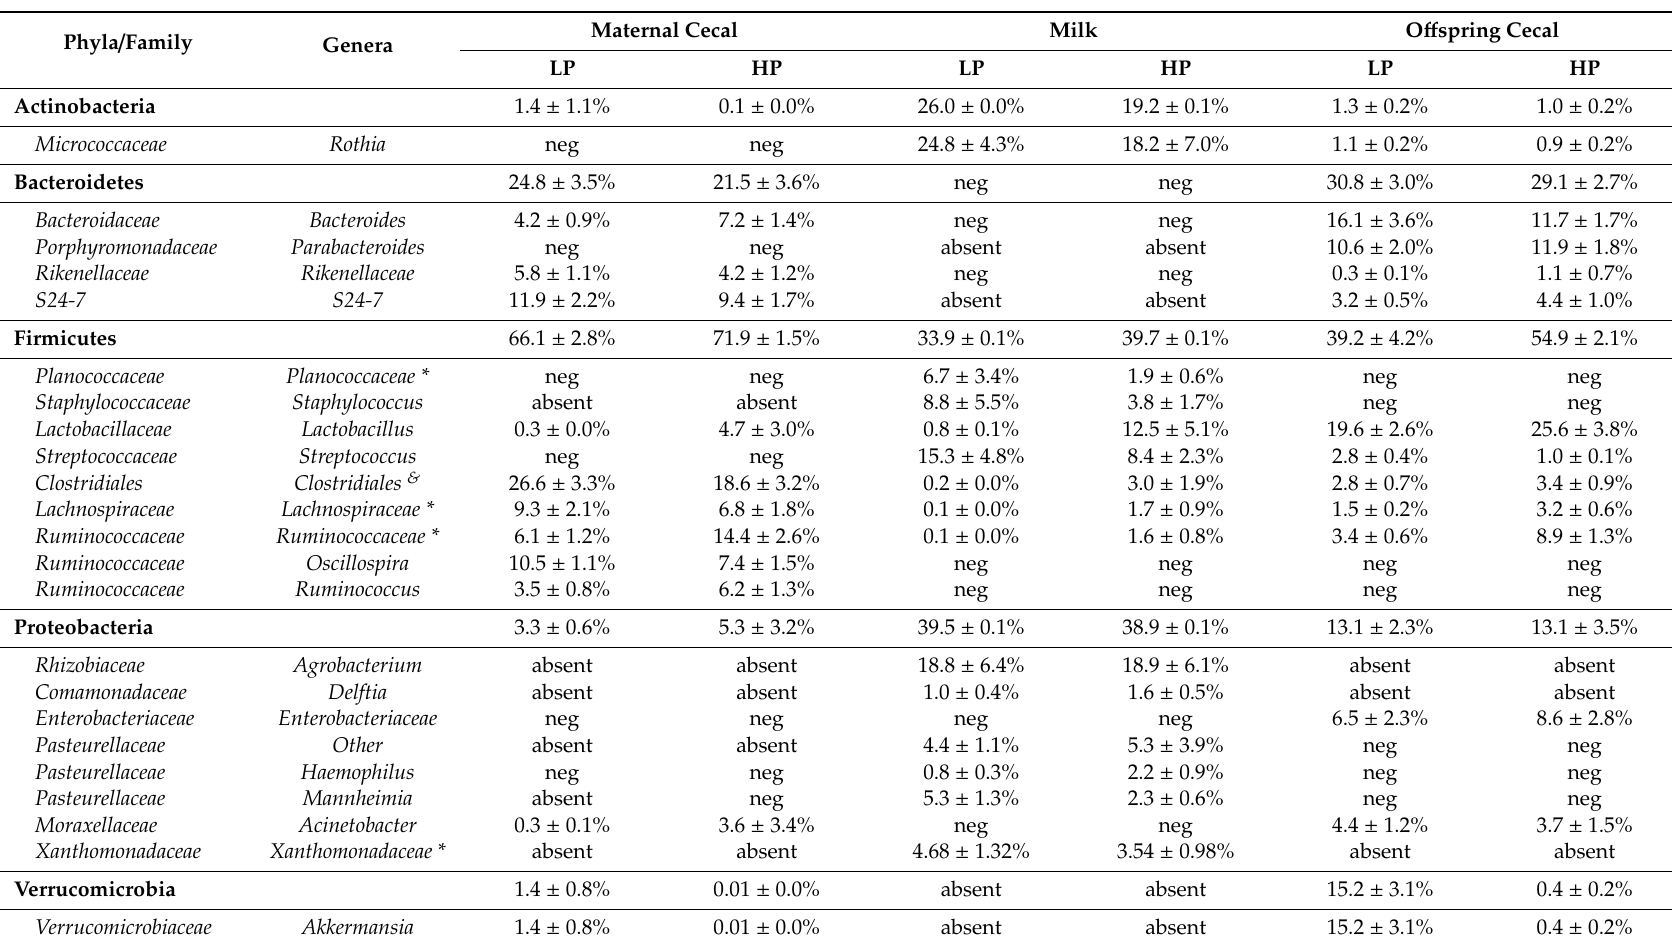
Table 3. Predominant bacterial phyla, families, and genera (percentage of reads) in maternal ceca, milk, and o ff spring ceca of rat dams fed a 10% protein (LP) or 20% protein (HP)